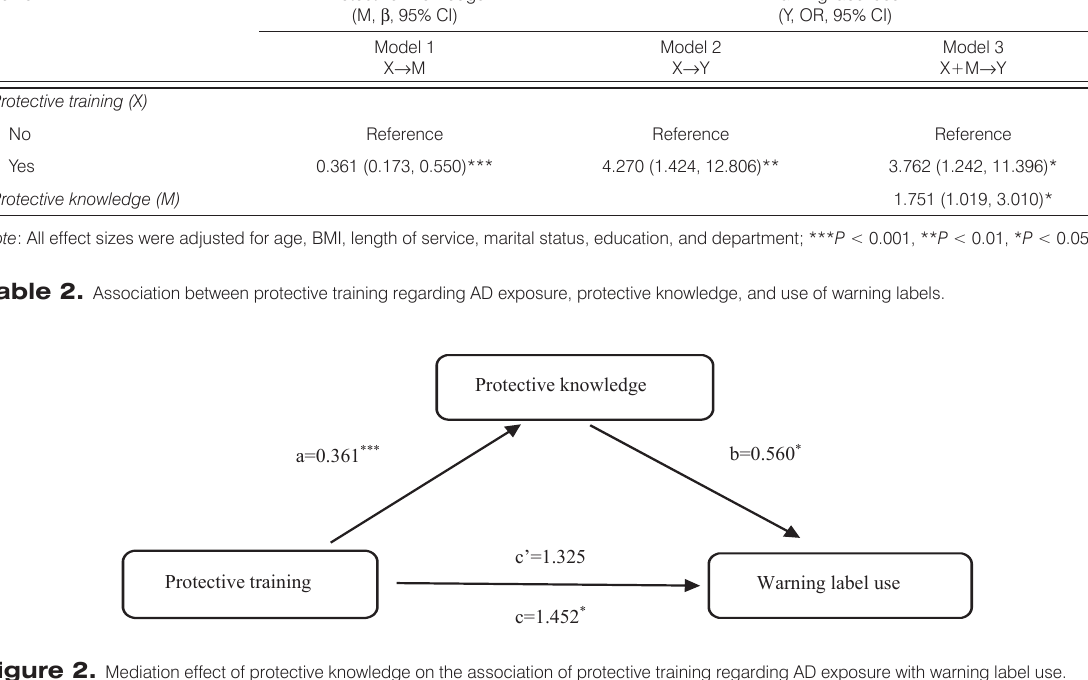
Figure 2. Mediation effect of protective knowledge on the association of protective training regarding AD exposure with warning label use. Note : The proportion of mediation = 23.4%.